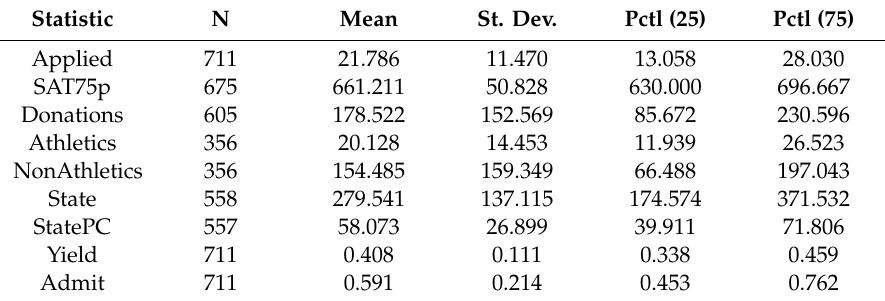
Table 1. Data profile, response